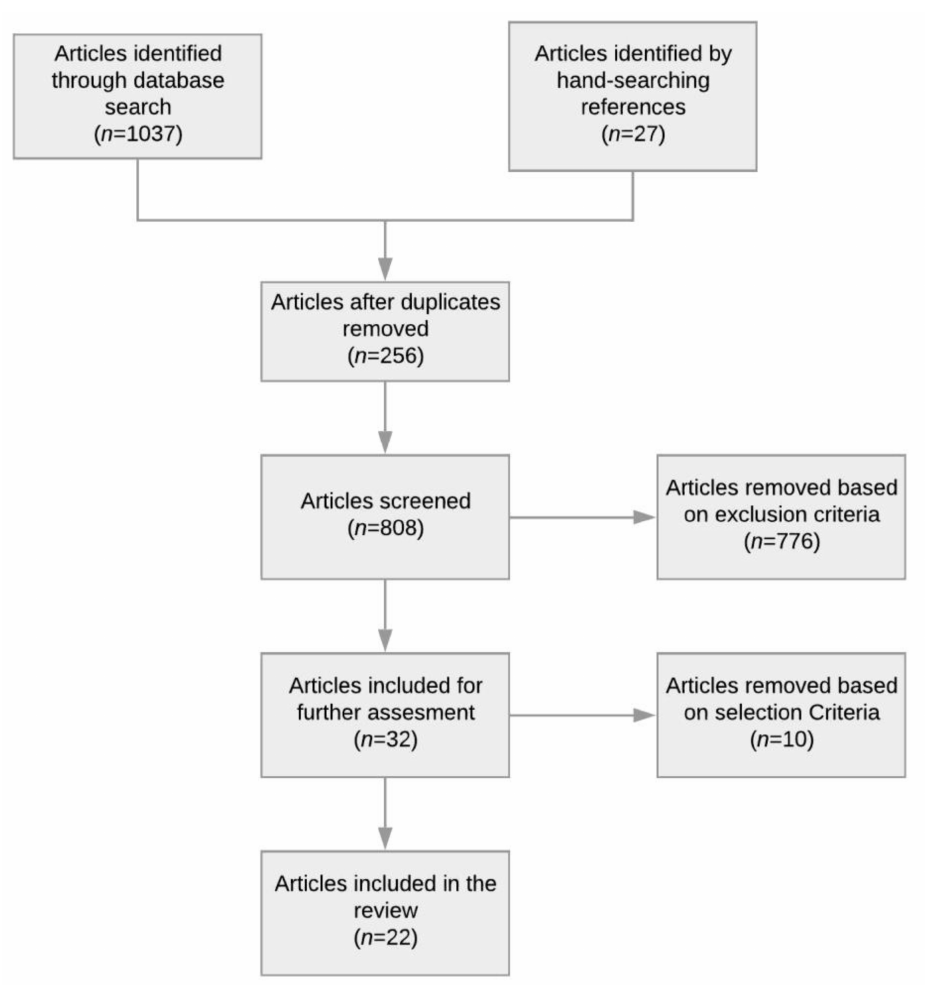
Figure 1. Flow diagram of literature search